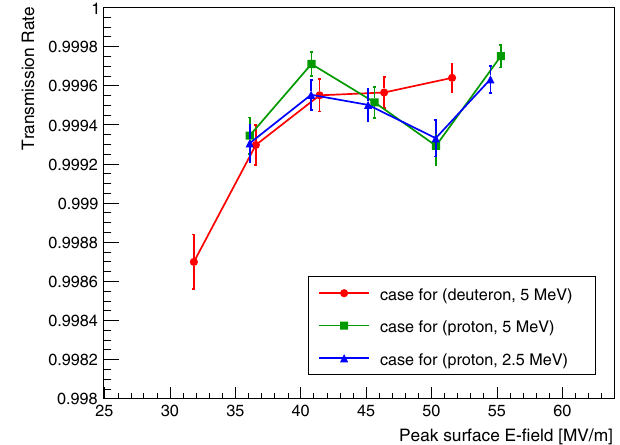
FIG. 11. Transmission rate through RFQ compared to the beam intensity at the RFQ entrance as a function of peak surface E- field. The vertical and horizontal axes represent the transmission rate and the peak surface E-field, respectively. The red circles denote the result of 5-MeV deuteron, triangles denote the result of 5-MeV proton, and the squares denote the result of 5-MeV